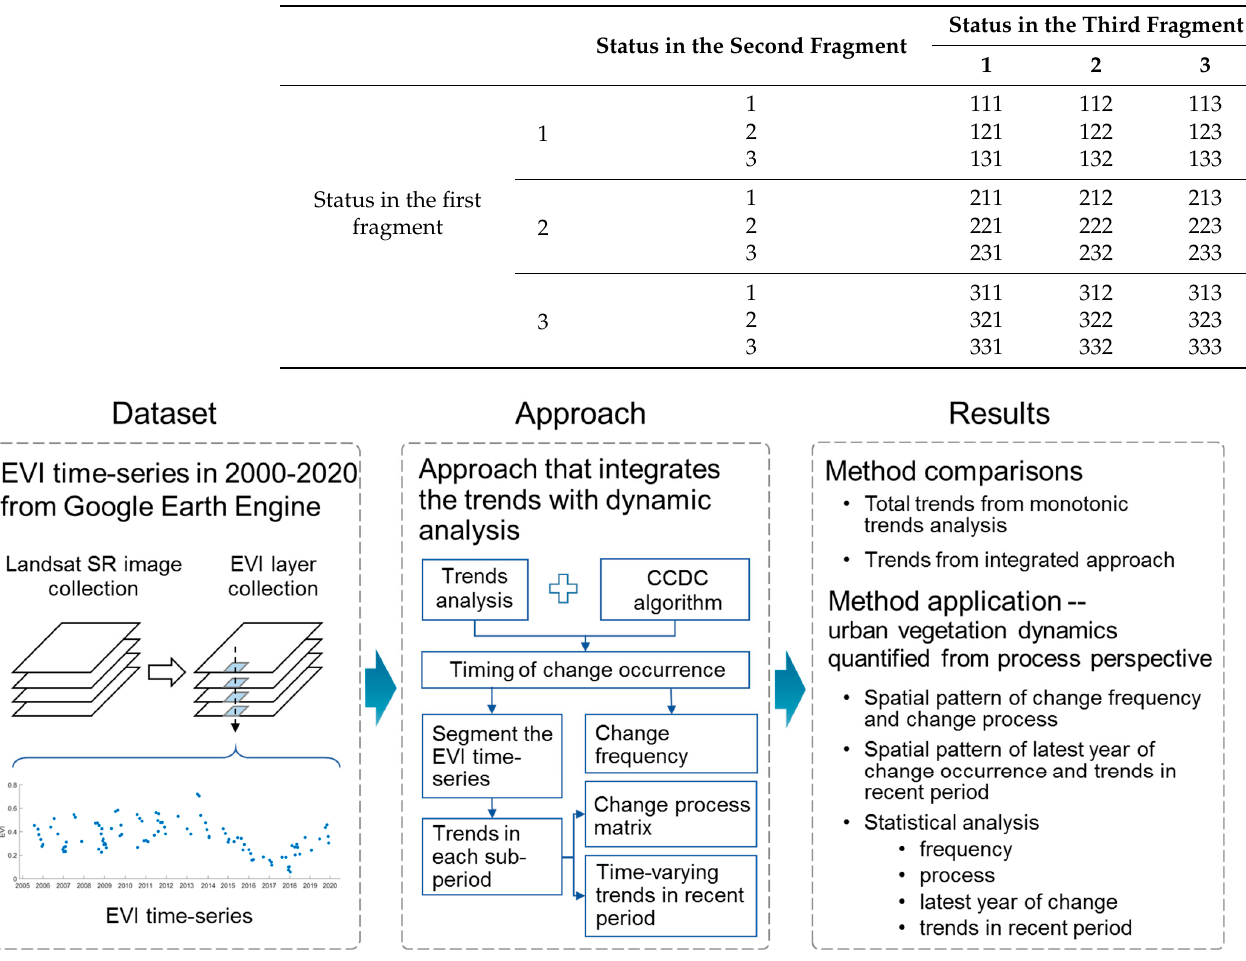
Table 1. Matrix for processes of vegetation dynamics based on the trends in each fragment with different duration.